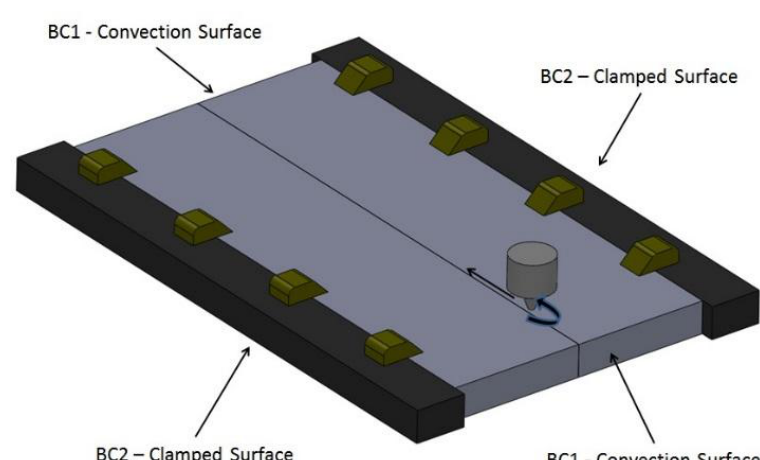
Figure 4. Schematic of FSW